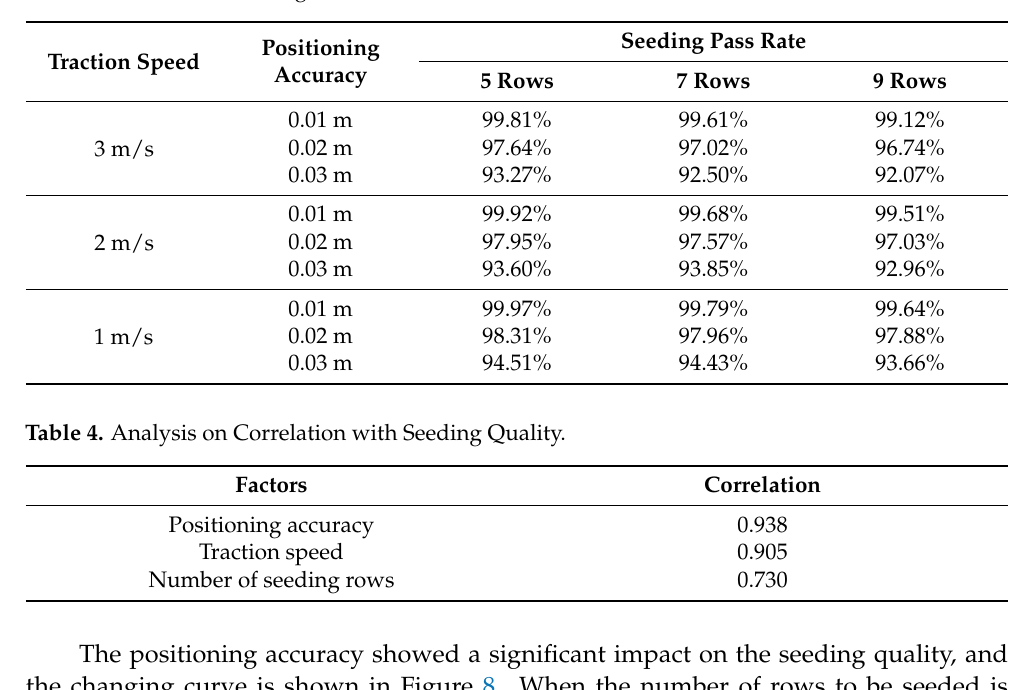
Table 3. Statistics of Seeding Qualification Rate.